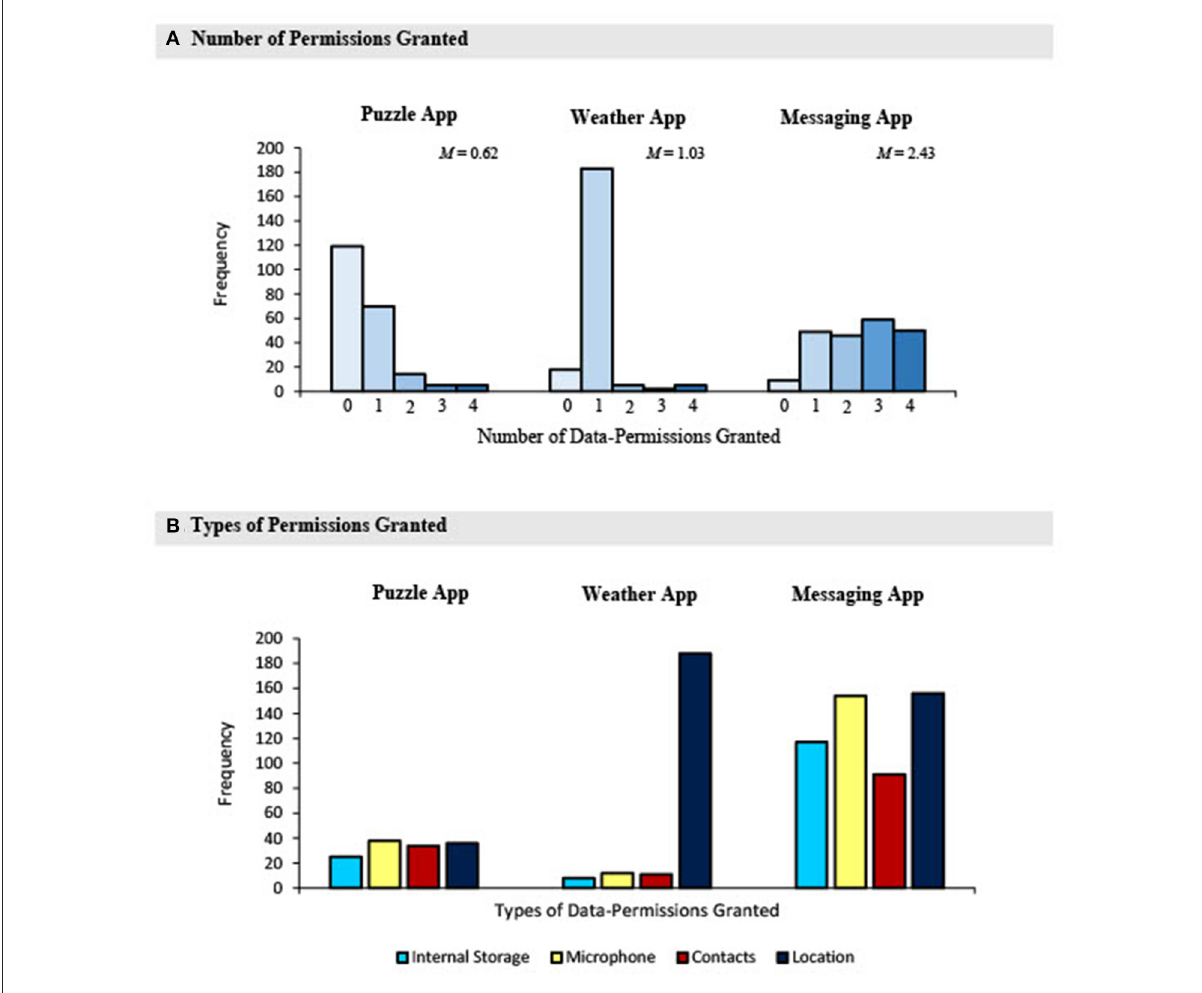
FIGURE3 Frequency of number (A) and Type (B) of Permissions Granted per App, Study